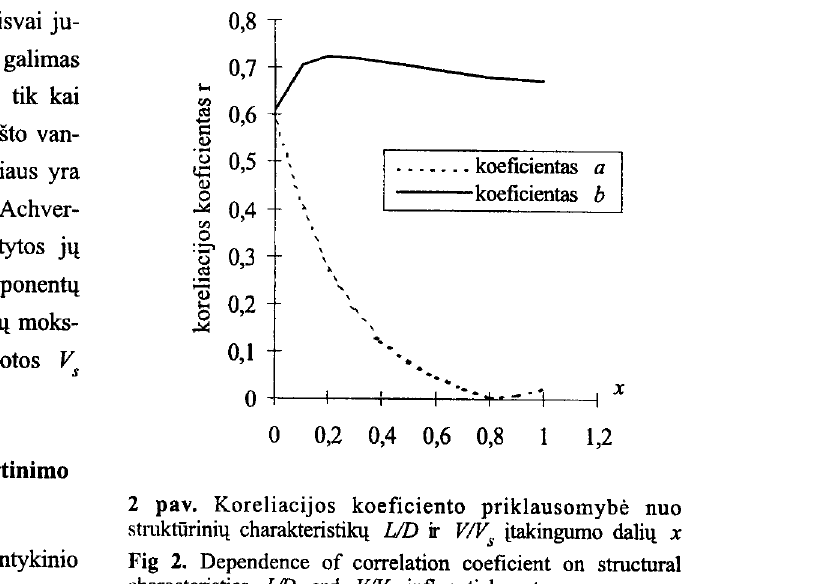
Fig 2. Dependence of correlation coeficient on structural characteristics IJD and V!Vs influential parts x procesui turi laisvasis vanduo ir skiedinines dalies tarpsluoksnio storis, t. y. atitinkamai sios